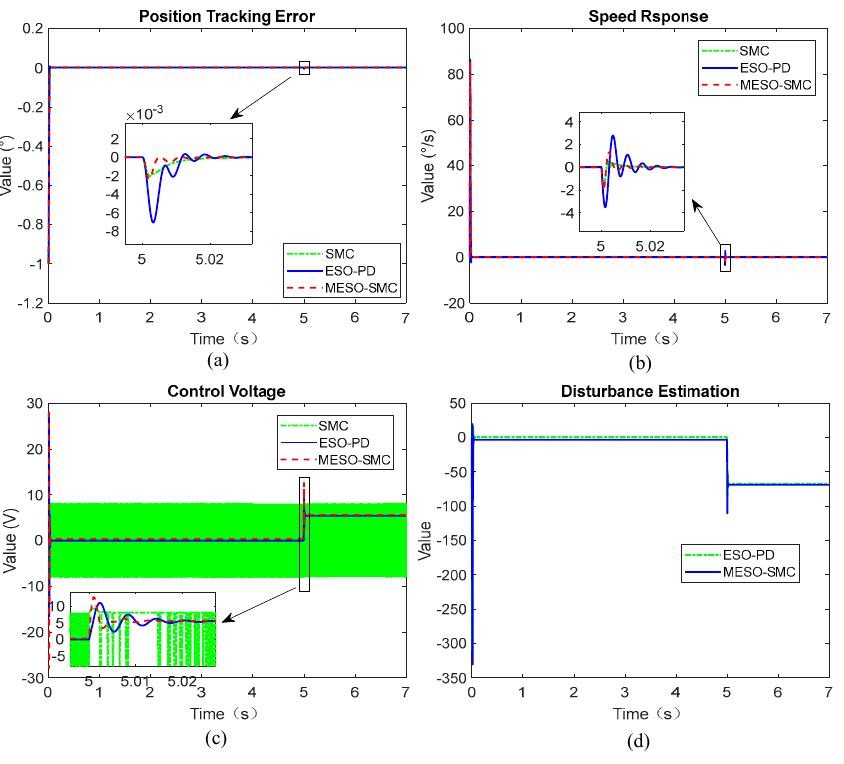
Figure 13. Step response comparations. ( a ) Position tracking. ( b ) Speed response. ( c ) Control voltage. ( d ) Disturbance estimation.